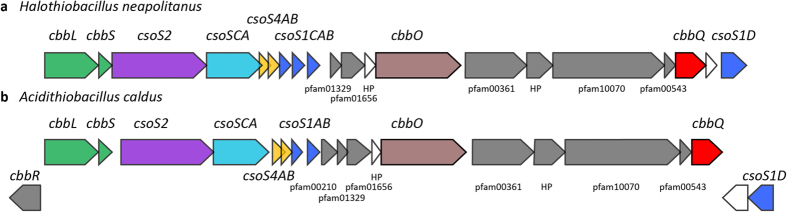
Gene neighborhood of carboxysome-associated cbbQ in H. nea (A) and (B). the representative α-carboxysome locus28
encoded in the genome of
Acidithiobacillus caldus. White colored genes are not conserved among loci28.